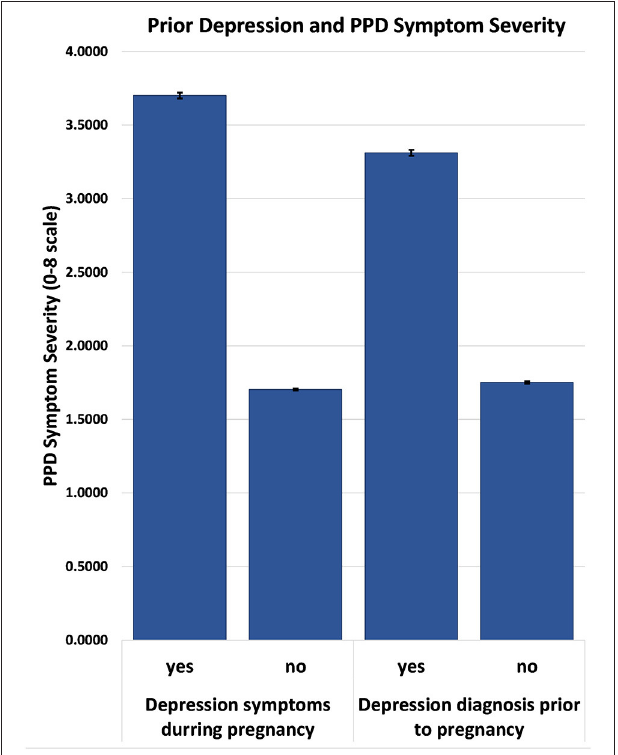
FIGURE 2 | Postpartum symptom severity based on response to previous depression diagnosis and depressive symptoms during pregnancy.